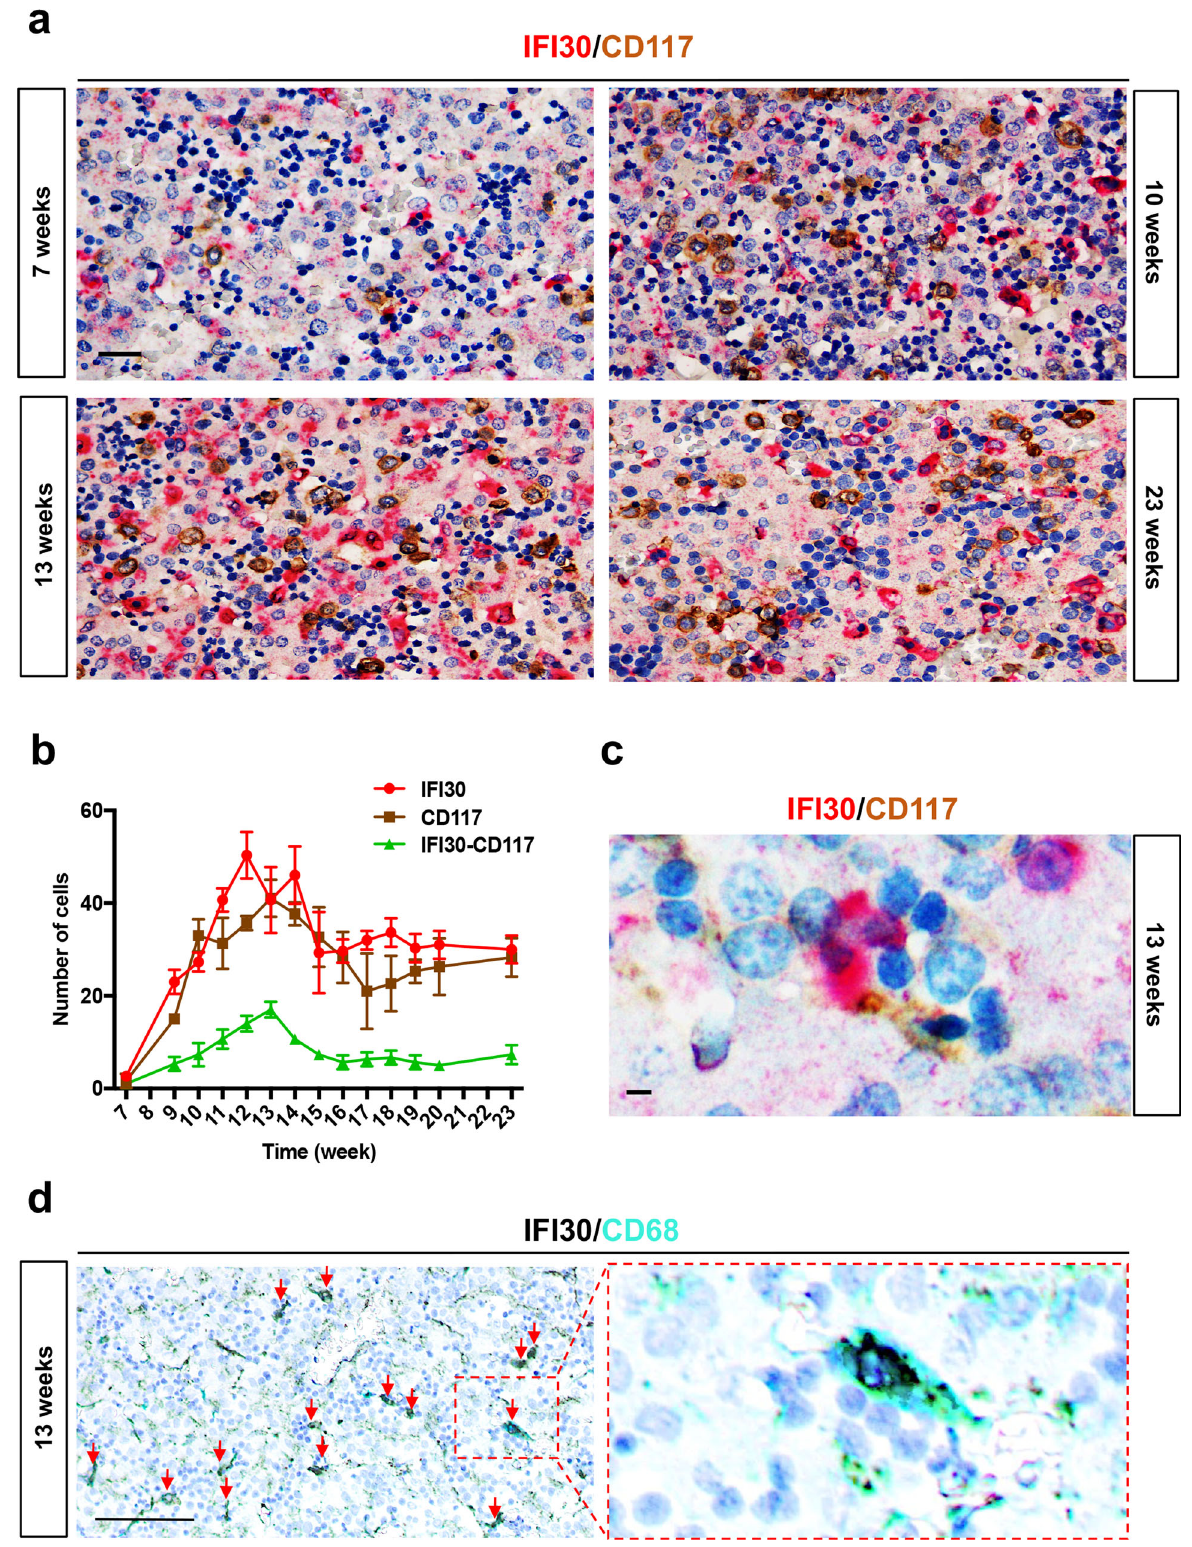
Fig. 7 HSPCs interact with IFI30 + cells in human fetal liver. a Double immunostaining against GILT/IFI30 and CD117 on sections of human fetal liver at different stages of gestation. b Distribution of GILT/IFI30 + cells (red line), CD117 + cells (brown line), and IFI30 + cells in contact with CD117 + cells (green line). For each developmental stage, only one human fetal liver sample was used ( N = 1), but three different sections were analyzed. c High magni fi cation of double immunostaining against GILT/IFI30 (red) CD117 (brown) and nuclei (blue), on sections of human fetal liver at 13 weeks of gestation. Scale bars: 10 μ m. d Double immunostaining against GILT/IFI30 (black), CD68 (cyan), and nuclei (blue) in sections of human fetal liver at 13 weeks of gestation. All red arrows point to double-stained cells. Scale bars: 100 μ m ( a ); 25 μ m ( c ); 200 μ m. Right panel shows a magni fi cation of the region delimited by the red dotted line ( d ).